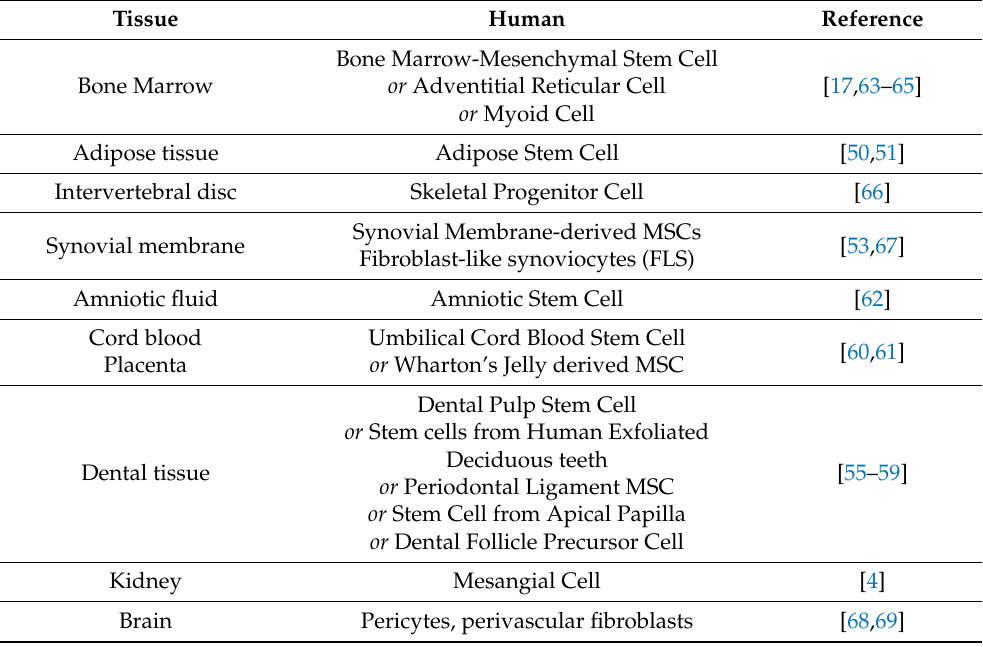
Table 1. The different names given to Multipotent Mesenchymal Stem/Stromal Cells (MSC) and their tissue